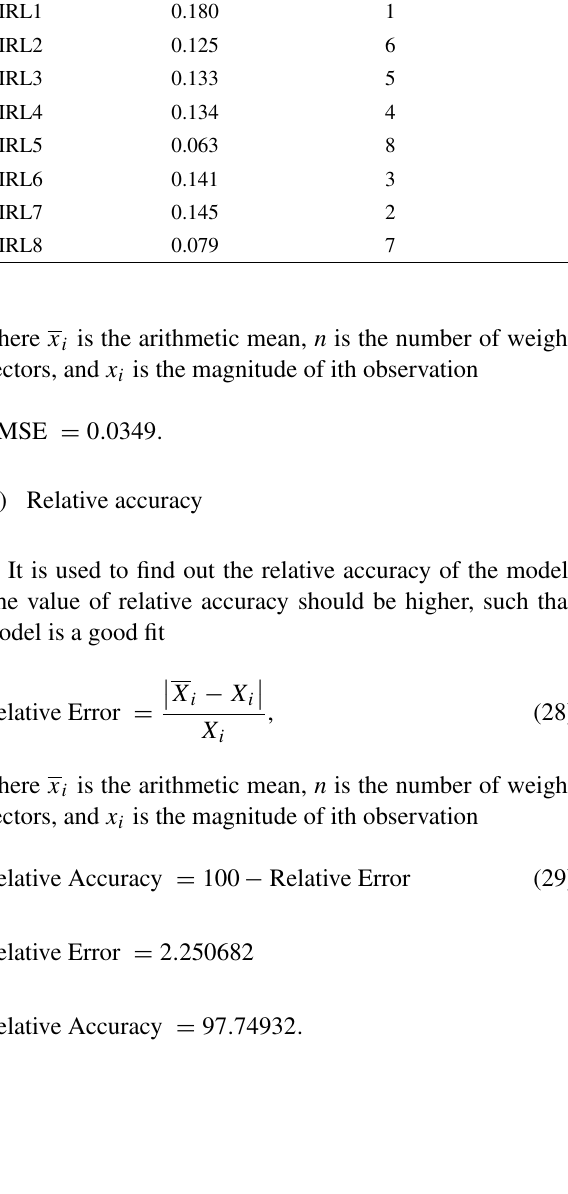
Table 8 Comparison of weights and ranking of IRL problems Criteria/problems Normalized weights Ranking of